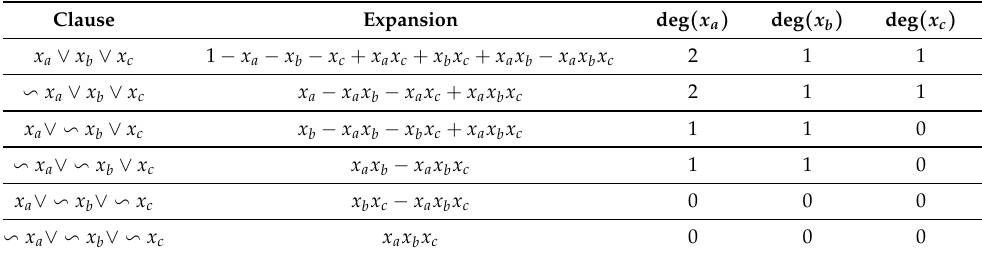
Table 1. The product reformulation and expansion of 3-SAT clauses. In this chart, we let x b x c = u b , c . The last three columns count the contribution to the degree of each variable from the monomials in two vertices that are not substituted. This contribution is only added the first time the two variable monomial appears. For example, if x a x b appears in more than one clause, we only add one to the degrees of x a and x b . Since x b x c = u b , c , we do not add one to the degrees of x b and x c whenever x b x c appears in a clause. The number in each degree column is added to the degree from Theorem 2 to calculate the degree of vertex x i in the derived